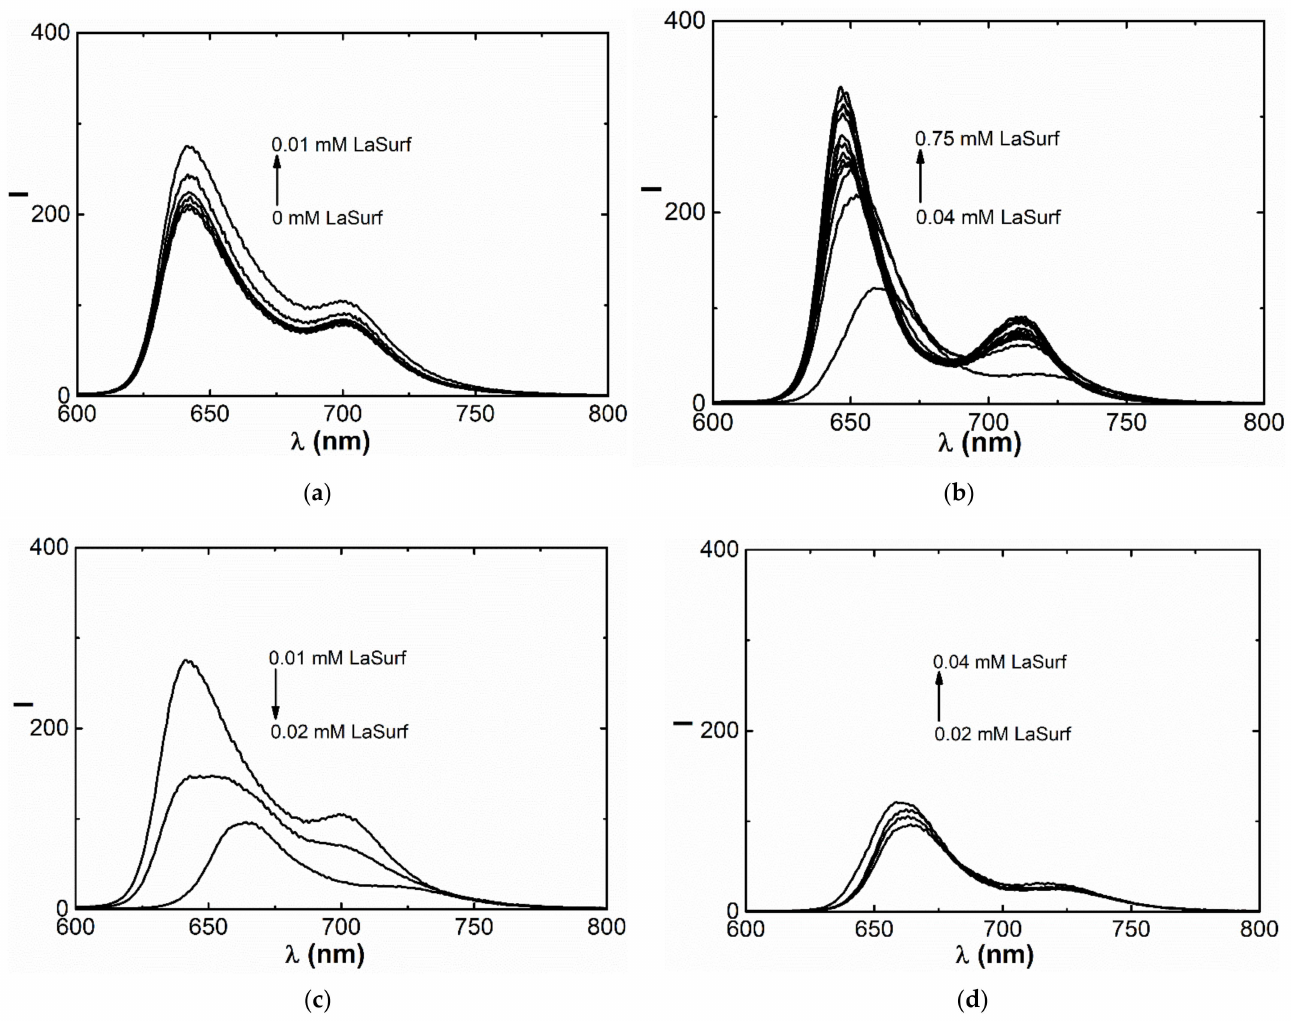
Figure 4. Fluorescence spectra of TSPP (0.01 mM) in the presence of ( a ) 0–0.01, ( b ) 0.01–0.02, ( c ) 0.02–0.04, and ( d ) 0.04–0.75 mM